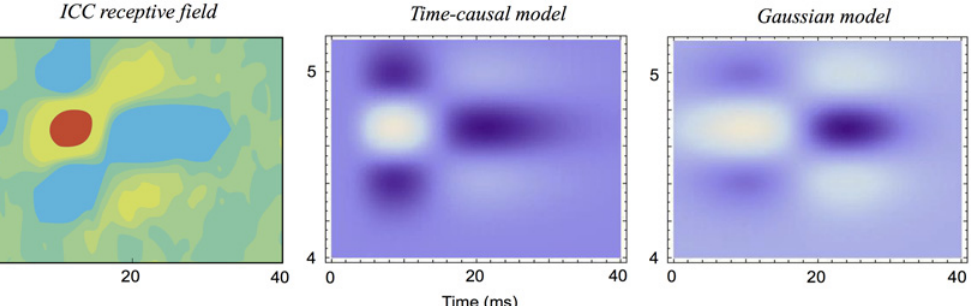
Fig 15. (left) A separable monaural spectro-temporal receptive field in the central nucleus of the inferior colliculus (ICC) of cat as reported by Qiu et al. [31] (schematic simplification only, see fig. 2(a) in [31] or fig. 16 in [64] for the original data). (middle and right) Idealized receptive fields models (90) corresponding to a first-order derivative with respect to time and a second-order derivative with respect to logarithmic frequency centered at ν = 4.7 octave, temporal scale σ t = 7 ms, logspectral scale σ ν = 0.17 octave for both models and additionally temporal delay δ = 17 ms for the Gaussian